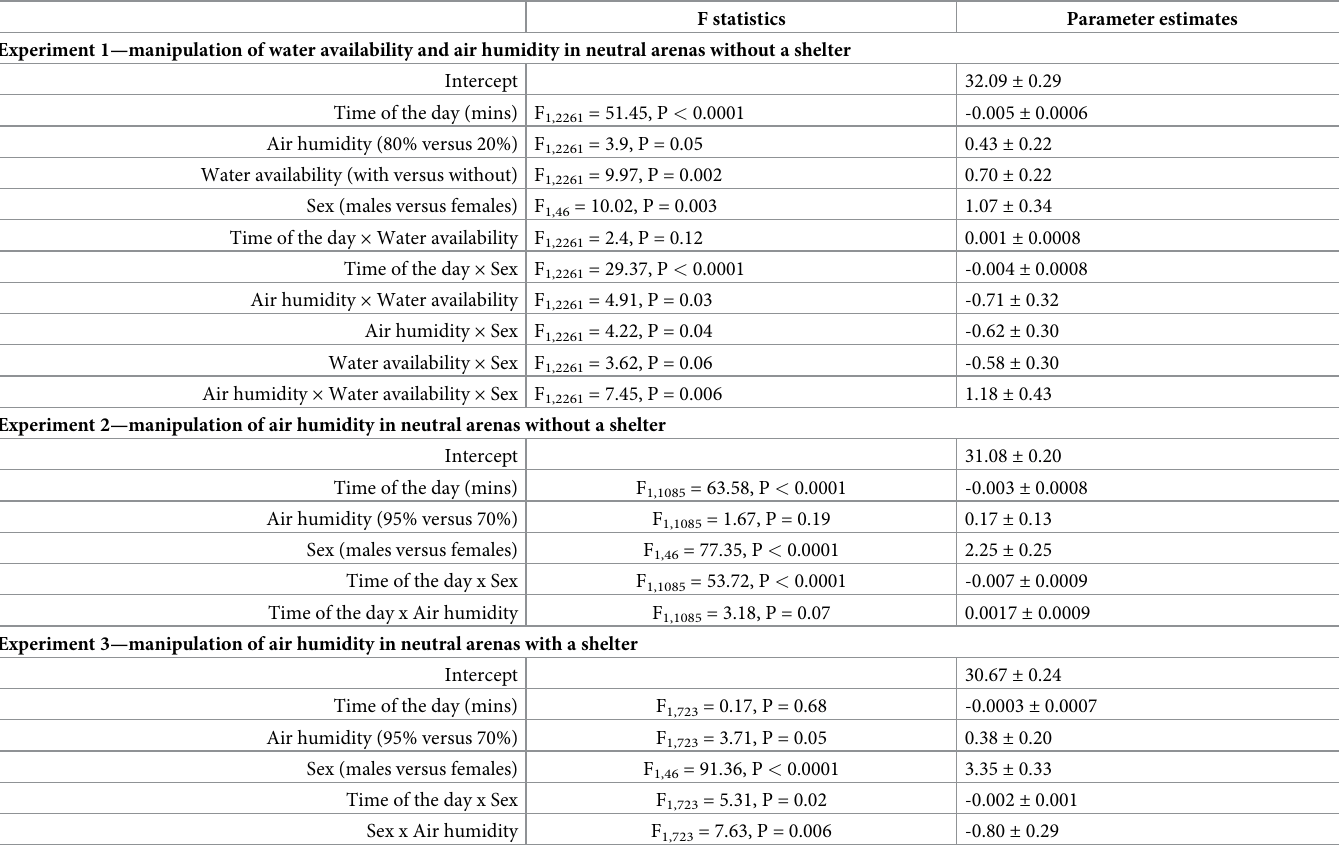
Table 2. Best selected models for intra-individual variation in body temperature (˚C) in experiments 1 to